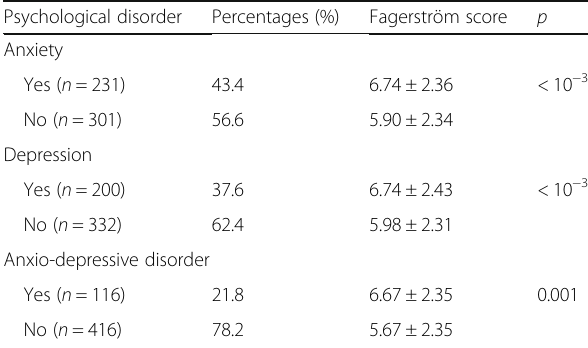
Table 3 Anxio-depressive disorders according to Fagerström score among the attendees of the smoking cessation clinic of the University Hospital Sahloul, Sousse, 2009 – 2015 Psychological disorder